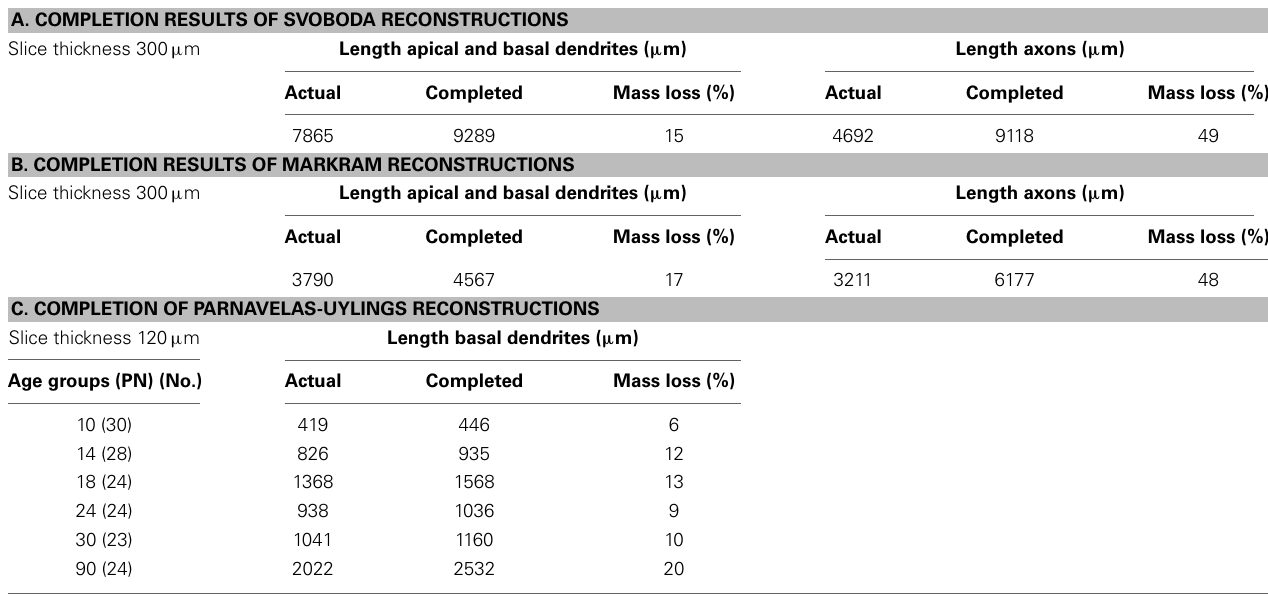
Table 2 | Outcomes of the completion procedure applied to (A) the dataset of Svoboda, (B) the dataset of Markram, and (C) the Parnavelas-Uylings datasets of all age groups in the developmental study, viz. 10, 14, 18, 24, 30, and 90 days PN.